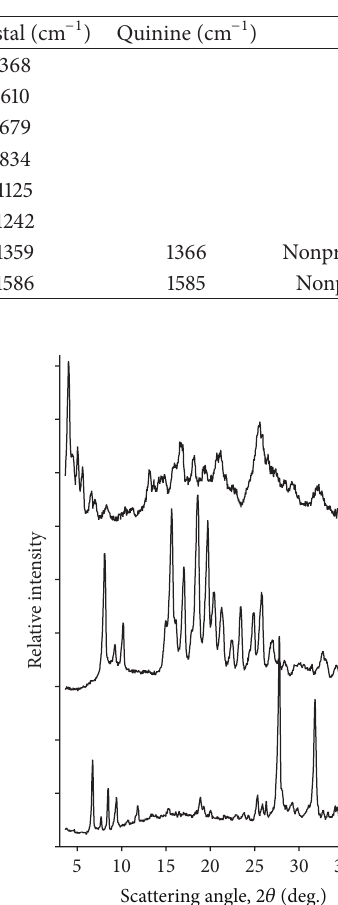
Table 6: Assignments of the major bands in the fingerprint region of the Raman spectra of 5-nitrobarbituric acid, quinine, and their 1:1 cocrystal product.